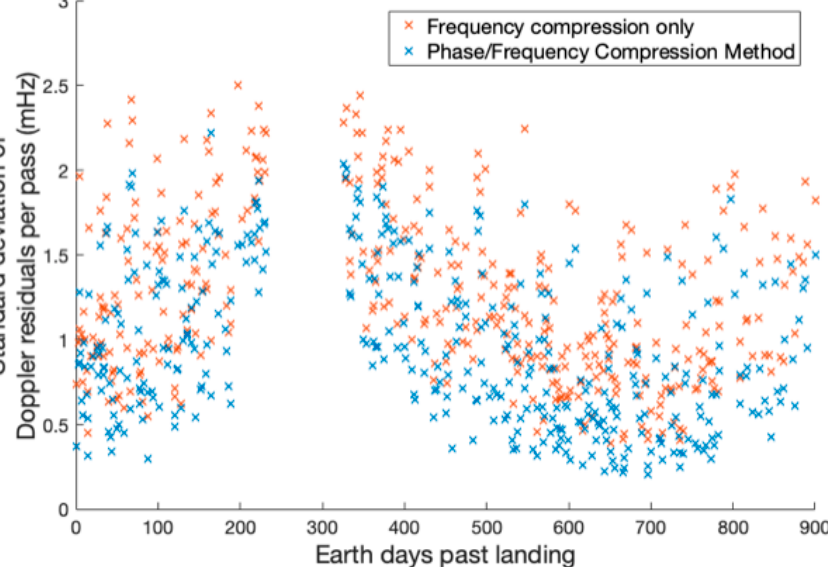
Figure 6. Standard deviation of Doppler residuals at 60 s count time for all passes in the first 900 days of operations. Only the standard deviation of the described phase/frequency compression method and the traditional frequency compression are shown.